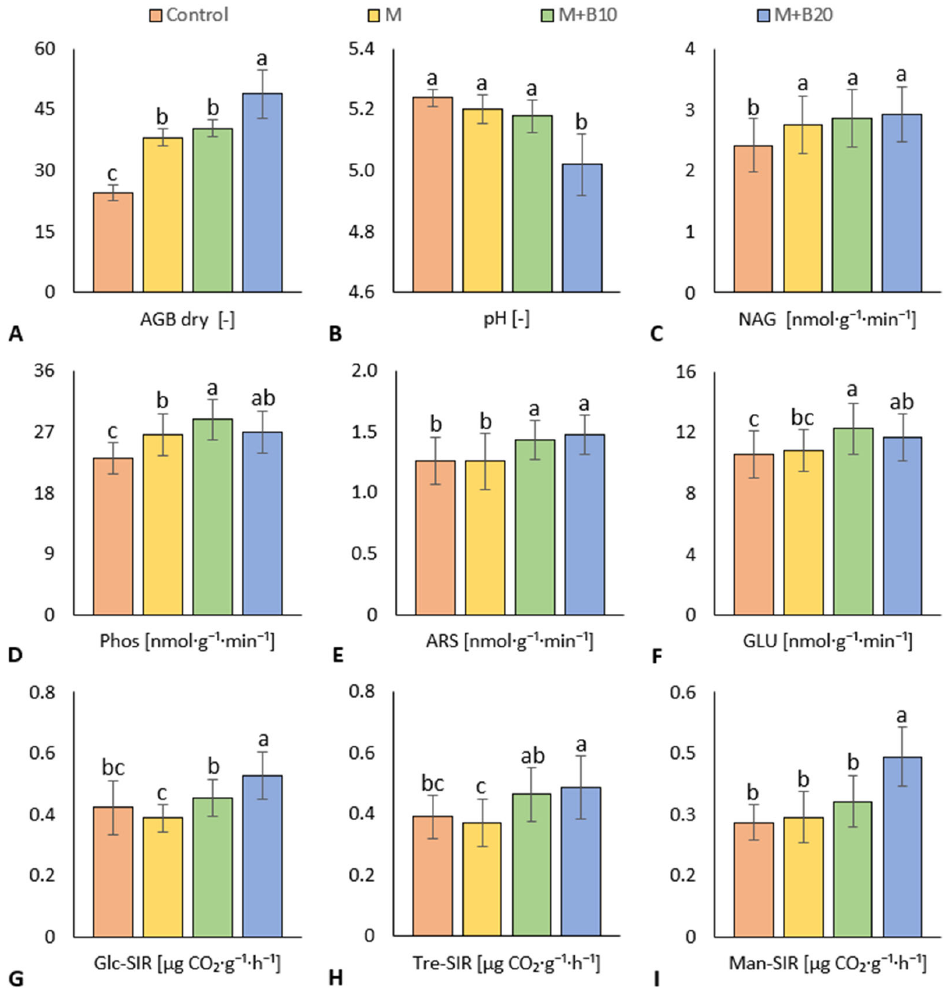
Figure 2. Dry aboveground biomass ( A ), soil pH ( B ), N-acetyl- β -D-glucosaminidase ( C ), phosphatase ( D ), arylsulfatase ( E ), β -glucosidase ( F ), D-glucose-induced soil respiration ( G ), D-trehalose- induced soil respiration ( H ) and D-mannose-induced respiration ( I ) in treatments amended with poultry litter produced from untreated and biochar (10 and 20% w / w )-enriched litter. Displayed are mean values with error bars (standard error of mean); letters indicate differences between values at the statistical level of significance p ≤ 0.05.